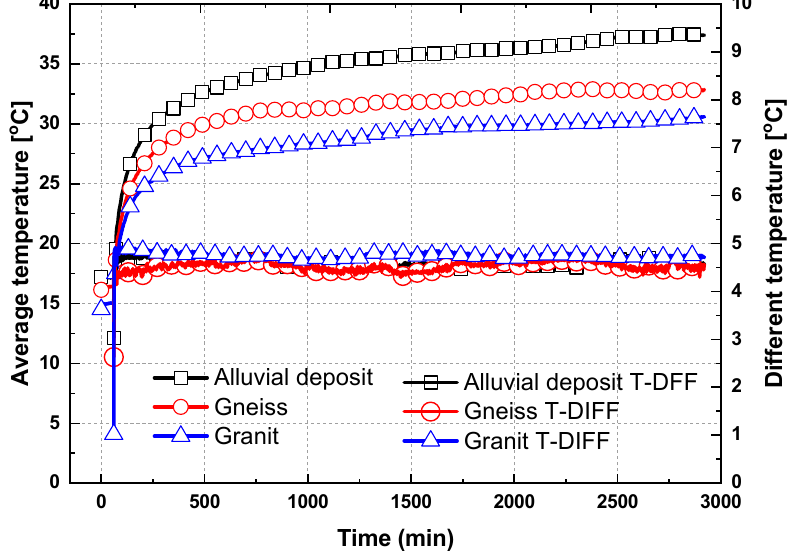
Figure 6. Average temperature distribution of various of rocks.